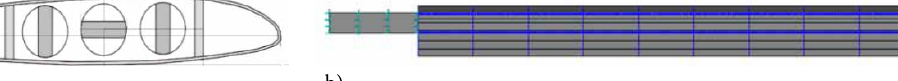
cross-sectiona) Fig. 1. Blade model construction: a) plan view; b)